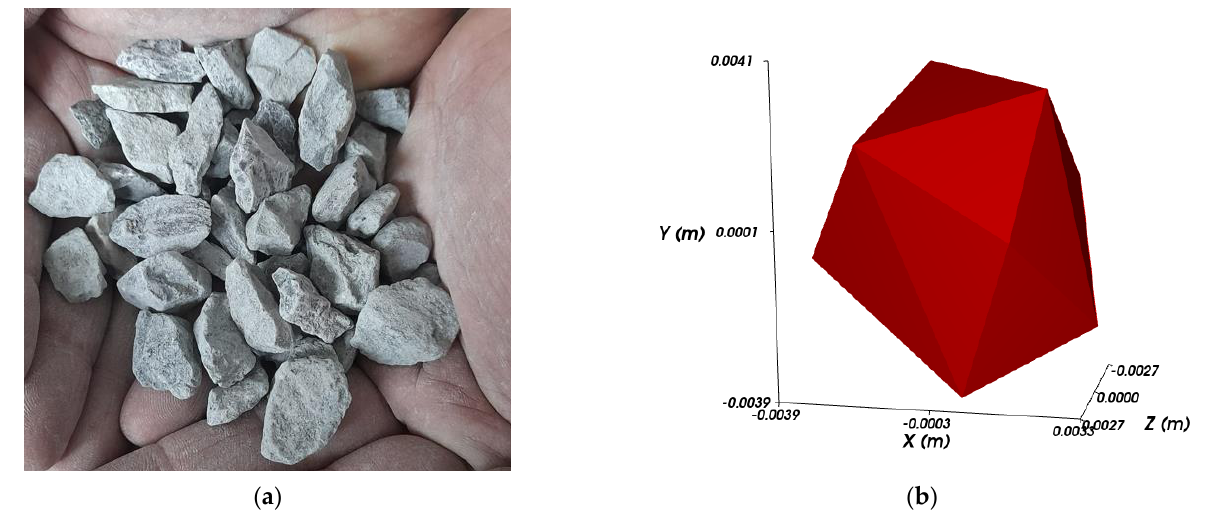
Figure 3. The particles used in the analysis: ( a ) the real shape of the aggregates, ( b ) the shape and dimensions of the particles used in the DEM analysis.